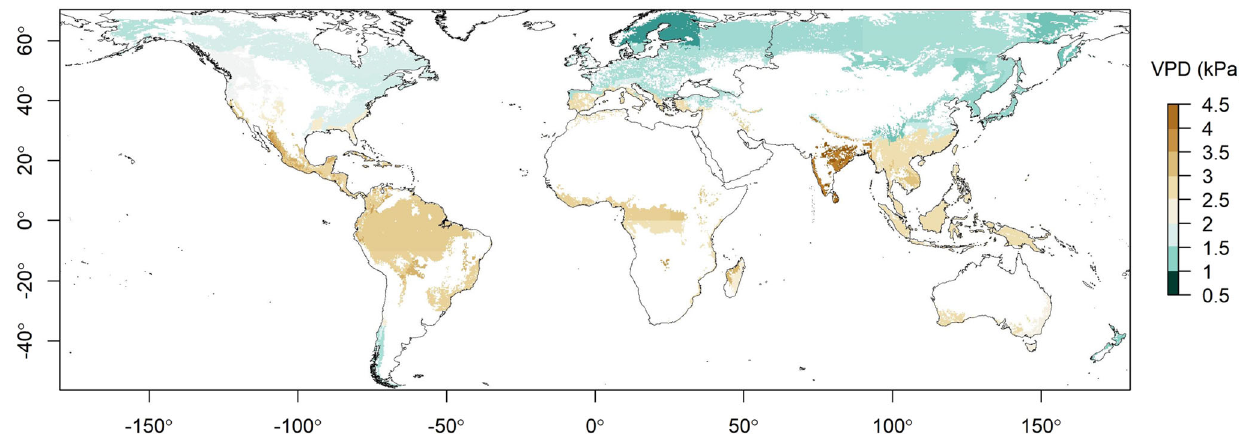
Fig.2|VPDthresholds(kPa)for fi reactivityinglobalforestbiomes. ThresholdvaluesindicatethedailyVPDabovewhichtheprobabilityof fi reexceeds50%,asderived from generalised linear modelling of historical climate and fi re records. The white areas indicate non-forest